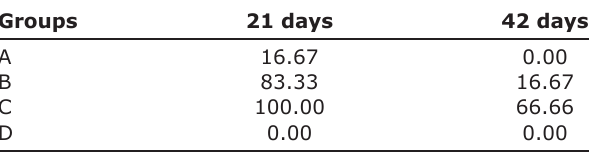
Table-2: Percentage of piglets born from immune sows possessing LPB-ELISA antibody titre log against CSFV in different groups at different age (days).